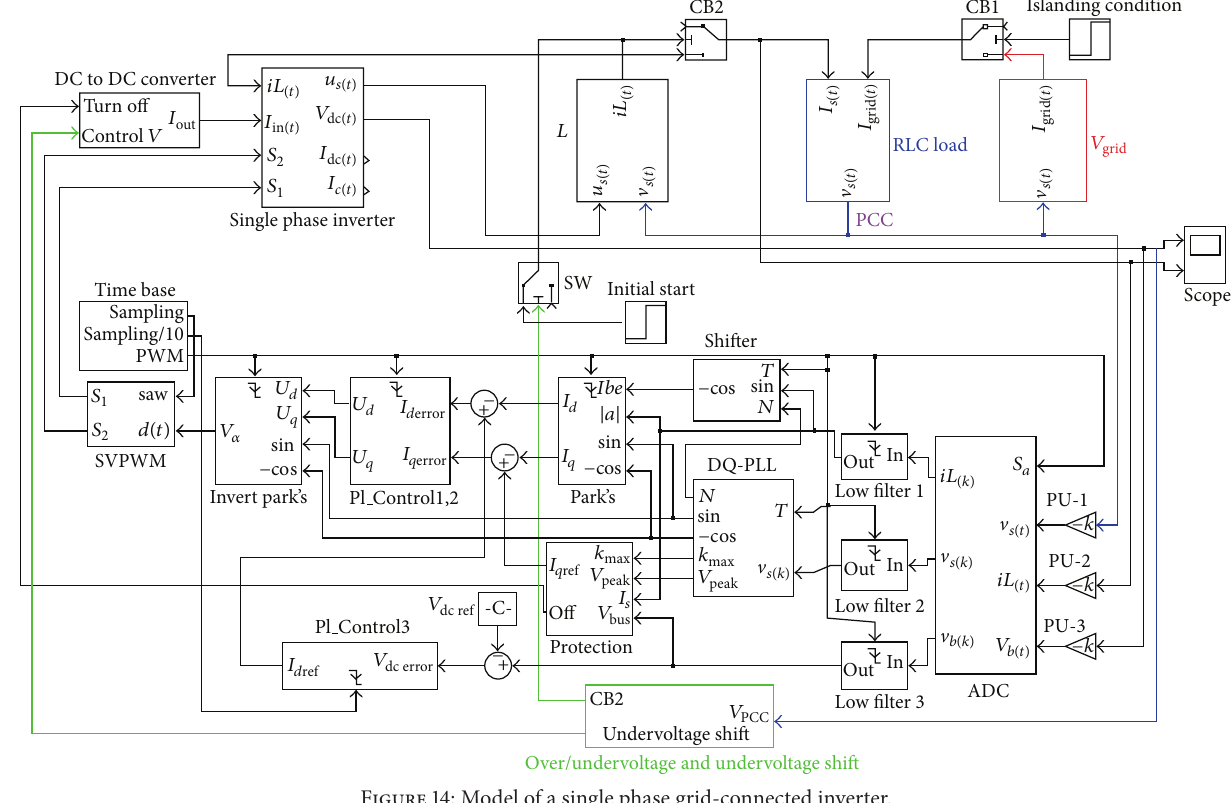
Figure 14: Model of a single phase grid-connected inverter.